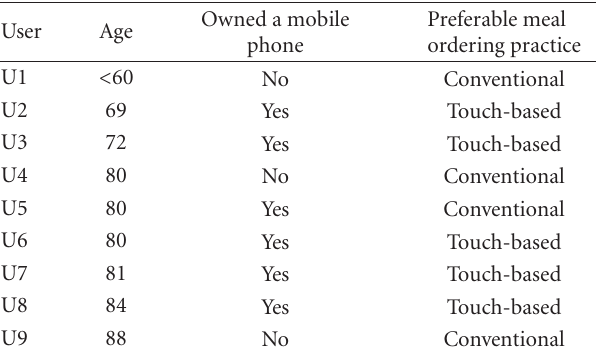
Table 1: Preferences for the